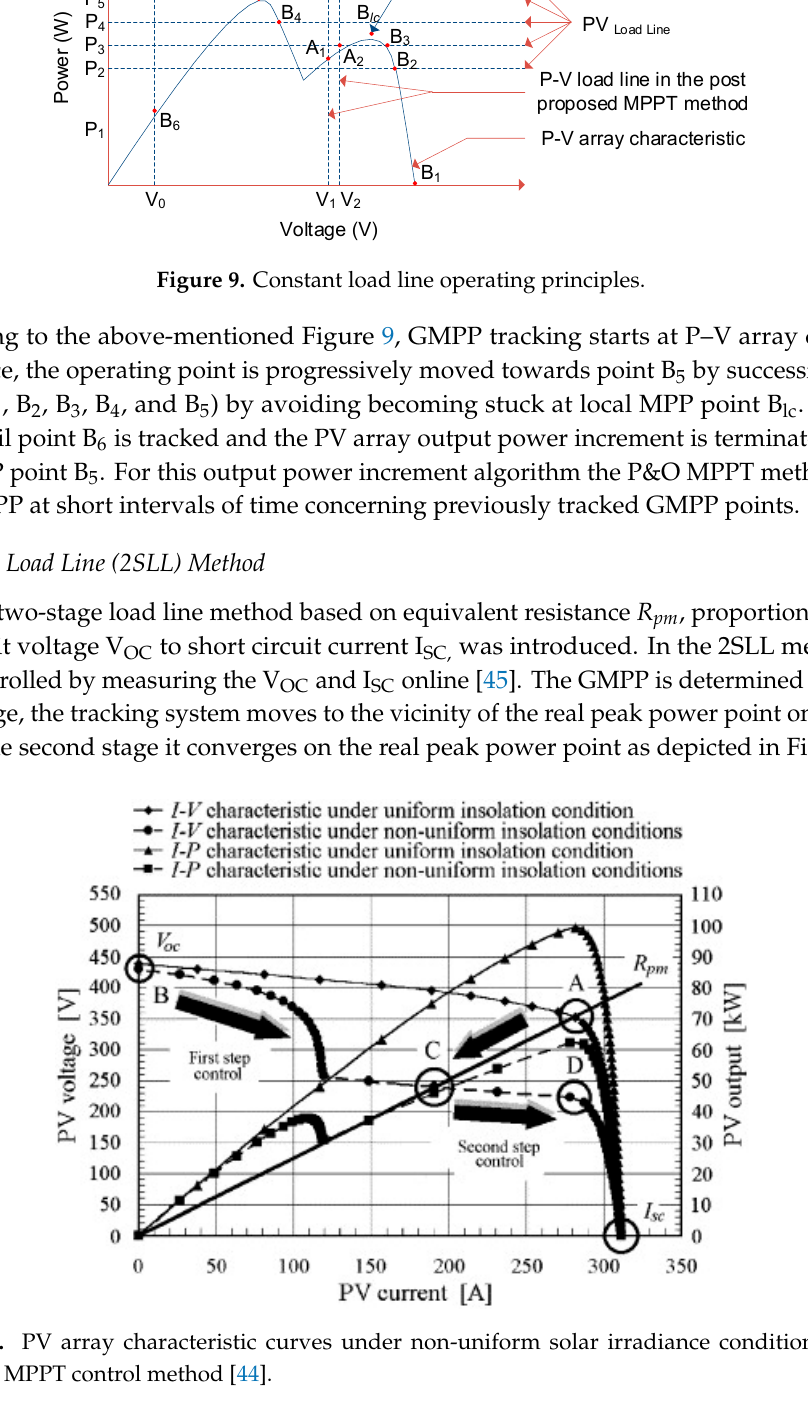
Figure 10. PV array characteristic curves under non-uniform solar irradiance conditions with a two-stage MPPT control method [44].